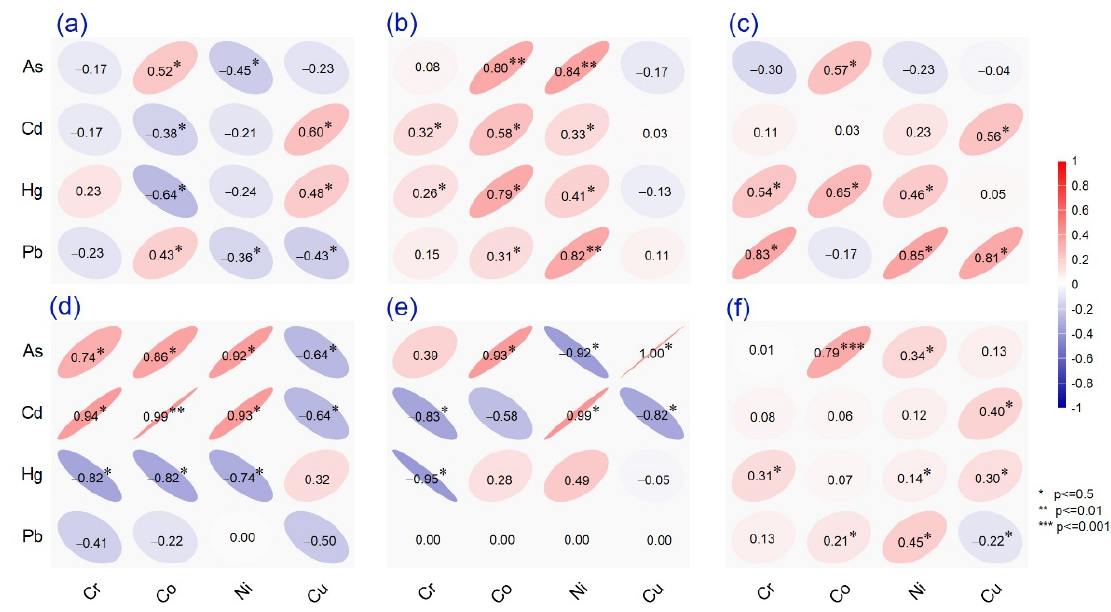
Molecules 2021 , 26 , x FOR PEER REVIEW Figure 2. Pearson product-moment correlation for eight metals measured in thirtieth spices from Romanian market grouped as ( a ) seeds, ( b ) leaves, ( c ) powder, ( d ) beans, ( e ) fruits and ( f ) include all samples investigated.